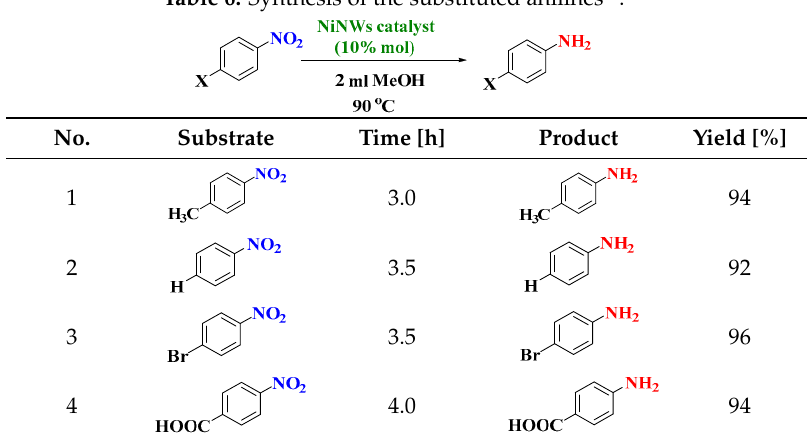
Table 6. Synthesis of the substituted anilines a .